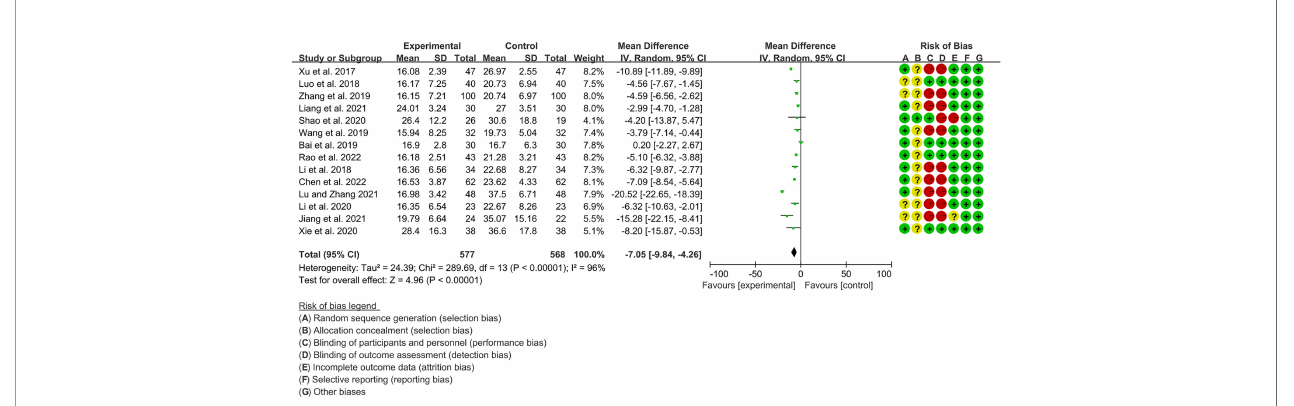
FIGURE 7 | The results of